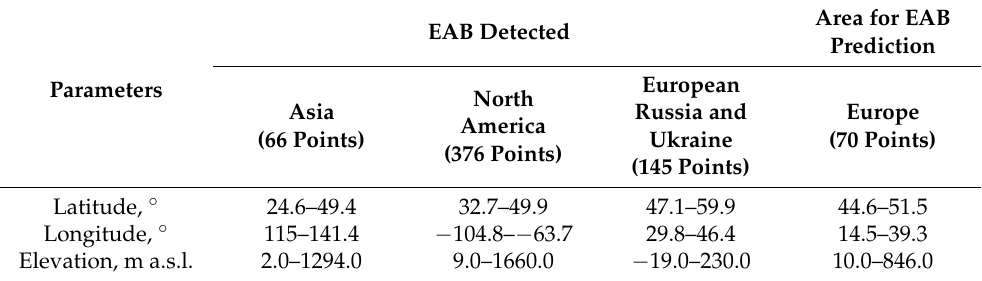
Table 4. Geographical diversity in native (Asia) and invasive EAB ranges (North America, European Russia, and Ukraine), as well as the area of EAB prediction. Area for EAB EAB Detected Parameters